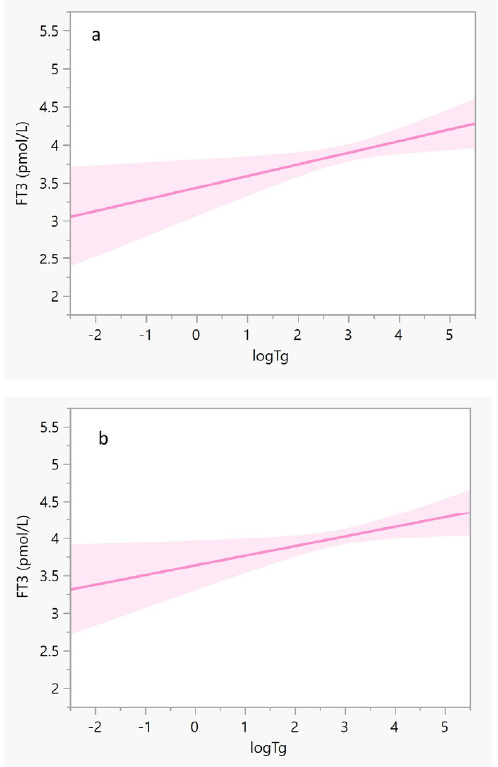
Figure 3. Regression lines of FT3 ( y ‐ axis) against log Tg ( x ‐ axis). The solid lines represent the estimated linear fit, and the shaded areas illustrate the 95% CIs. ( a ) Pregnant women in their third trimester ( N = 138): y = 3.4 − 0.2(x), and R 2 = 0.045; β (95% CI) = 0.19 (0.03, 0.27), p = 0.024; and ( b ) All pregnant women ( N = 178): y = 3.6 − 0.1 × (x), and R 2 = 0.032; β (95% CI) = 0.17 (0.02, 0.24), p = 0.024. After adjusting for participants’ age, smoking status, and gravidity, both correlations remained significant ( p = 0.04 for both). Abbreviations: CI, confidence interval; FT3, triiodothyronine; log Tg, serum log ‐ transformed thyroglobulin. Table 3. Iodine ‐ related dietary characteristics and thyroid function tests d of pregnant women and their newborn pregnancy outcomes and newborn anthropometrics by FT3 deciles.